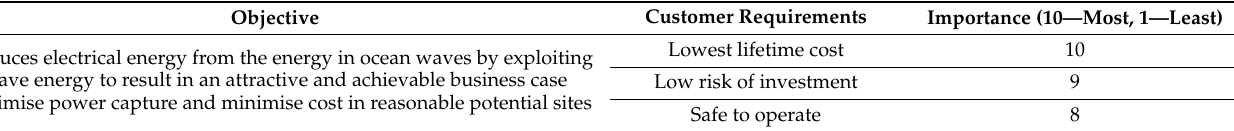
Table 2. Overall objectives, customer requirements, and ranking of importance for the example of novel wave energy concepts. The number and wording of objective(s) and customer requirements are determined by those completing the